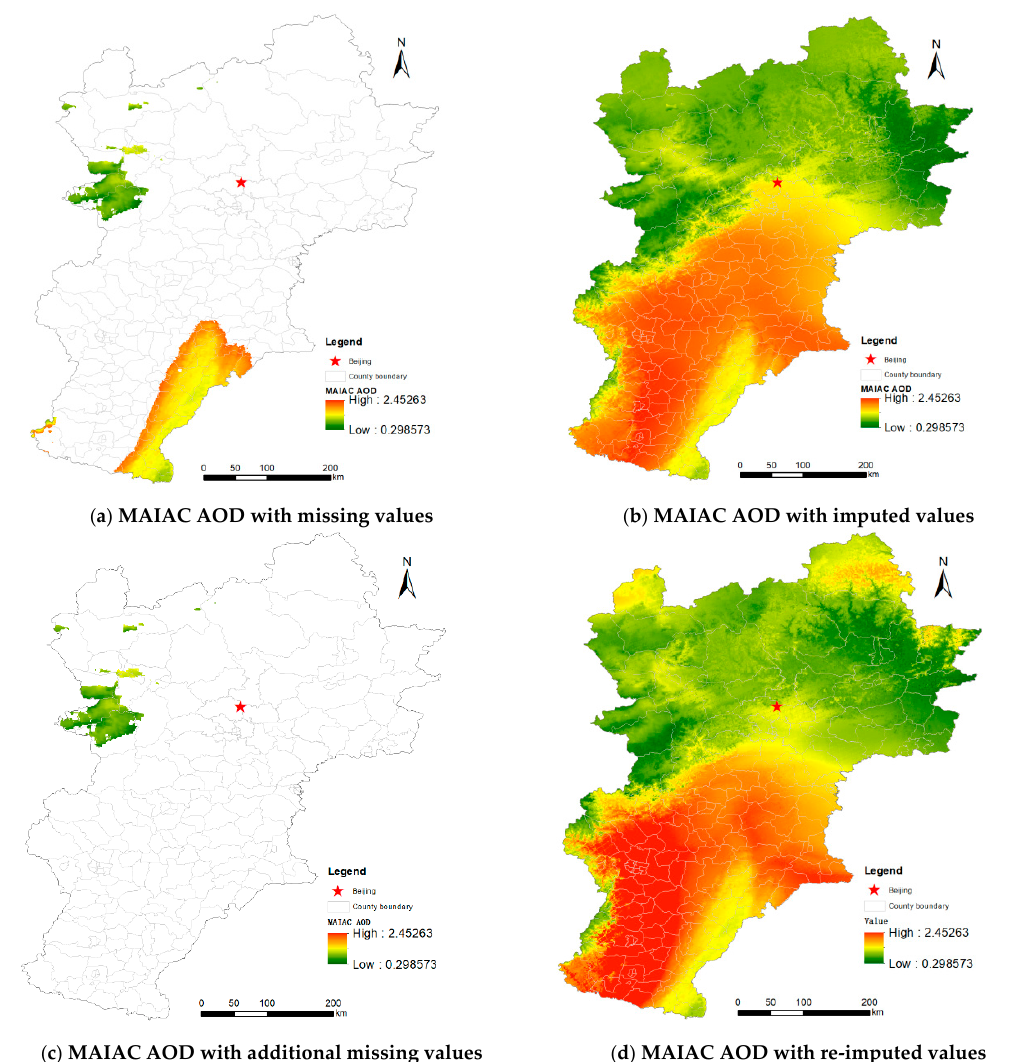
Figure 6. Original ( a ) and imputed MAIAC AOD ( b ), MAIAC AOD with additional missing values ( c ) and MAIAC AOD of re-imputed values ( d ) for a spring day (20 April 2015).